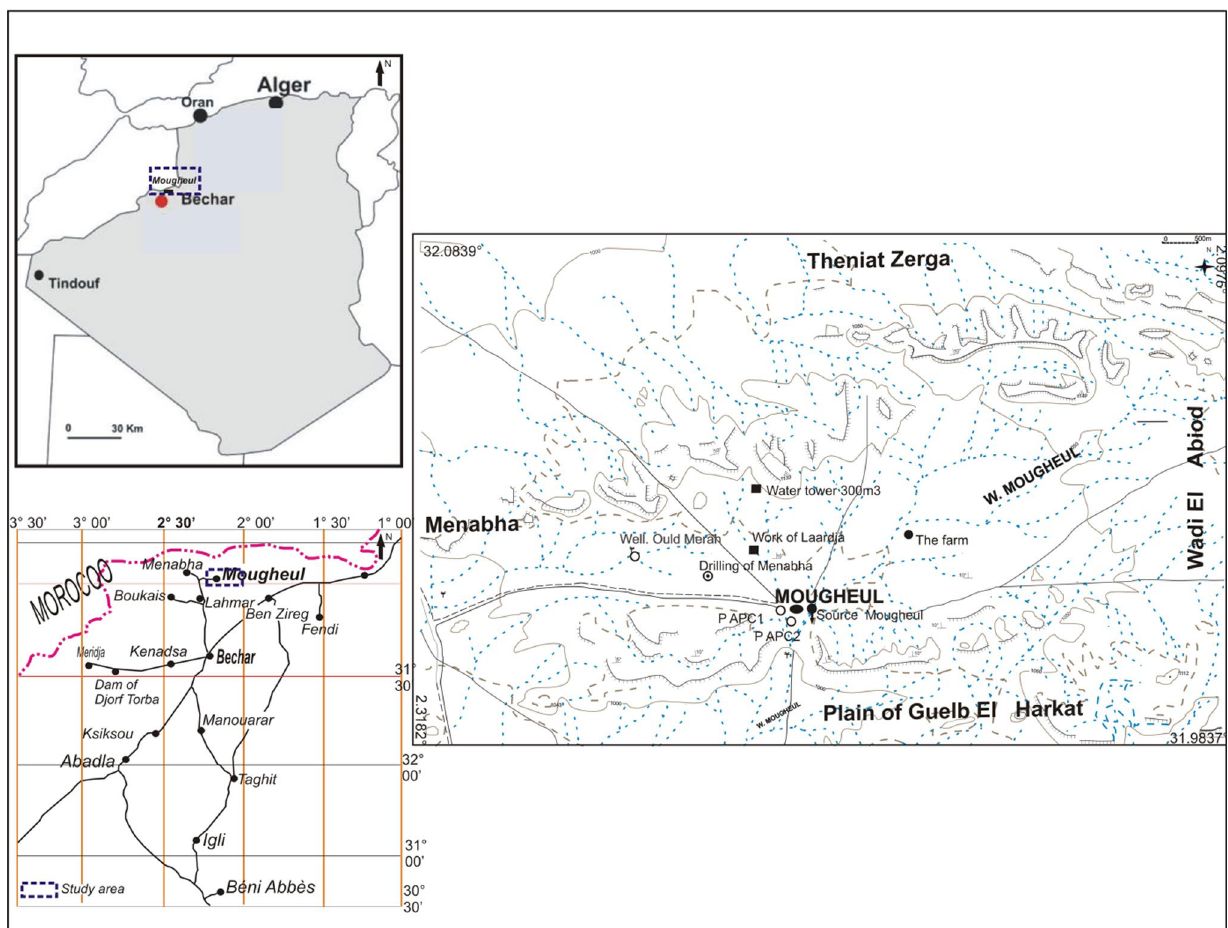
Fig. 1 Location of the study area (Kendouci